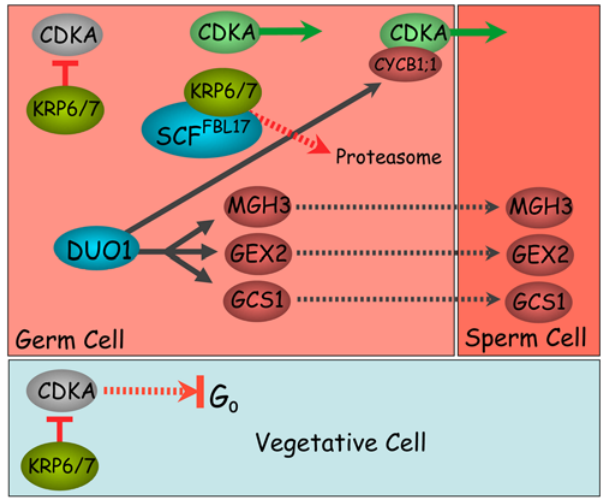
Figure 5. Regulatory events in plant male germ cell production and specification. Model integrating the role of DUO1 and SCF FBL17 [18] in plant germ cell production and specification. The germline- specific DUO1 protein (blue) activates the expression of several germline specific proteins (red). In parallel, the CDKA inhibitors KRP6 and KRP7 (green) are expressed in the vegetative cell and germ cell after asymmetric division, where they inhibit CDKA activity and S phase progression. The F-box protein FBL17 is then transiently expressed in the germline and forms an SCF FBL17 complex (blue) that targets KRP6/7 for proteasome dependent proteolysis, licensing S-phase progression (green arrow). Further germ cell cycle progression is controlled by the DUO1-dependent G2/M phase expression of the CDKA regulatory subunit AtCYCB1;1 (red). Thus, while SCF FBL17 and DUO1 promote male germ cell proliferation at successive stages of the cell cycle, DUO1 integrates germ cell specification and division to ensure the production of functional twin sperm cells that are essential for double fertilization. Arrows indicate a requirement for the protein rather than direct